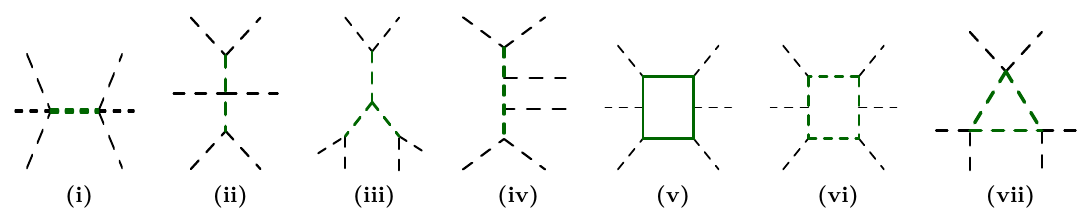
Figure 3 . Tree- (i)–(iv) and one-loop-level (v)–(viii) diagrams built of Lorentz invariant renormal- izable interactions of the UV theory that lead to effective operators of φ 6 class.